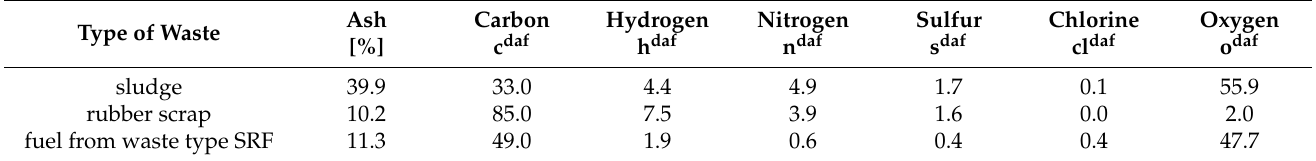
Table 2. Physicochemical properties of waste.